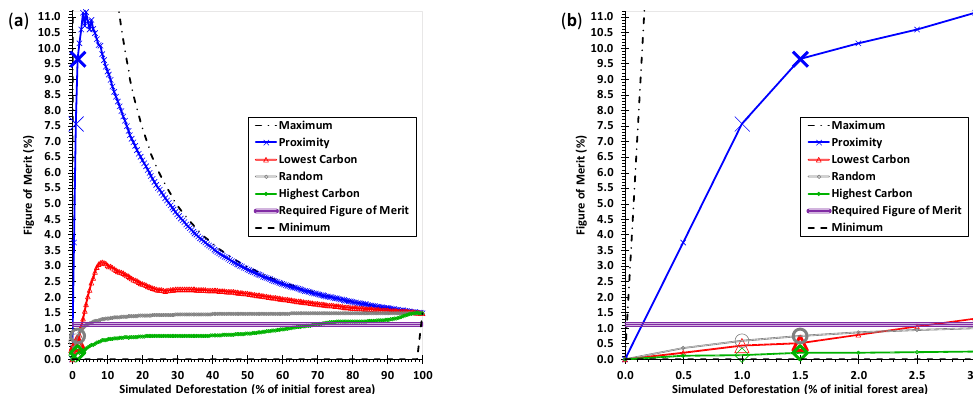
Figure 6. Figure of Merit versus deforestation quantity at ( a ) full range and ( b ) zoomed in.